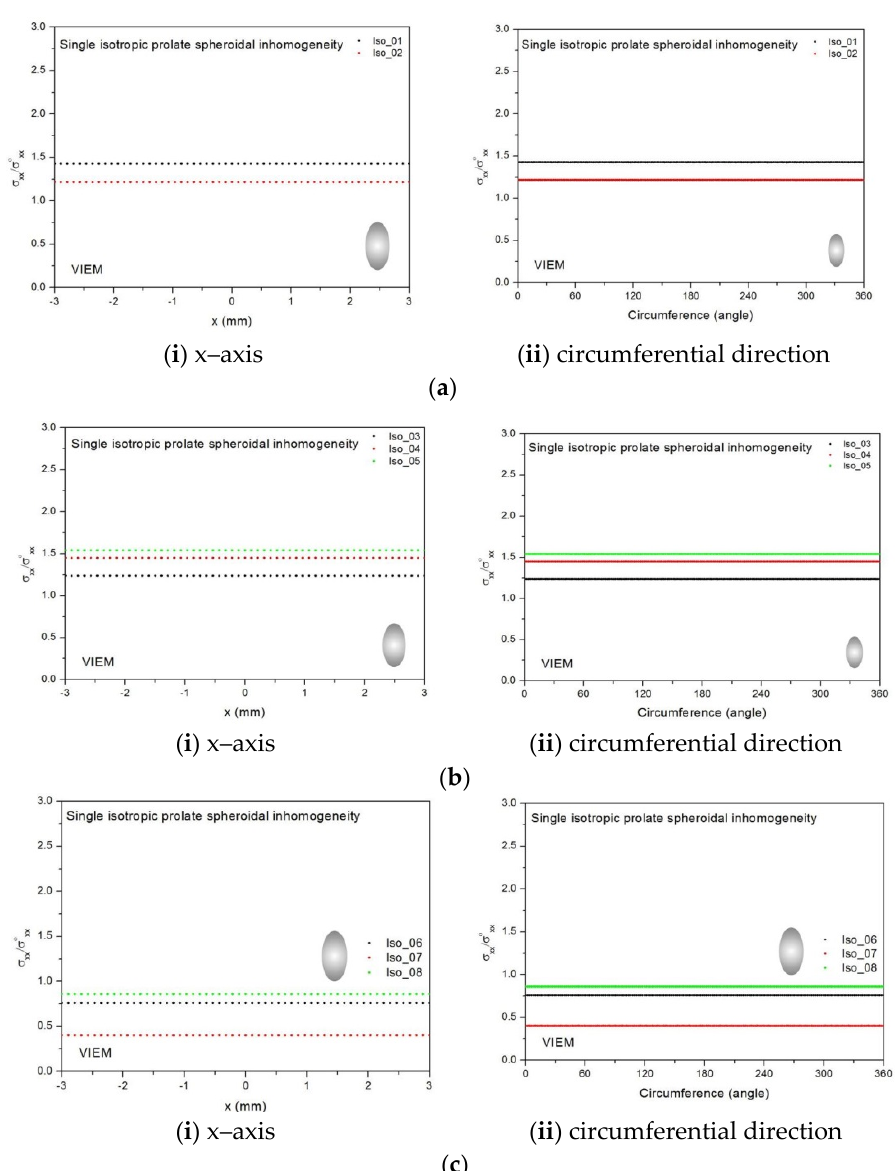
Figure 11. A typical discretized prolate spheroidal model (a/b = c/b = 0.75) in the volume integral equation method (VIEM). ( a ) An inside view of a prolate spheroidal model. ( b ) A prolate spheroidal model. Tables 10–12 show numerical solutions by the volume integral equation method for the normalized tensile stress ( σ xx / σ oxx ) inside the isotropic prolate spheroidal inclusions. For the inclusions in Iso_01, Iso_02, Iso_03, Iso_04 and Iso_05, the normalized tensile stress ( σ xx / σ oxx ) inside the inclusion was greater than 1.0. However, for the inclusions in Iso_06, Iso_07 and Iso_08, the normalized tensile stress ( σ xx / σ oxx ) inside the inclusion was less than 1.0. Figure 12 shows numerical solutions by the volume integral equation method for the normalized tensile stress ( σ xx / σ oxx ) along (i) the x–axis inside ( − 3 mm ≤ x ≤ 3 mm) and (ii) the circumferential direction (0° ≤ Ө (see Figure 10) ≤ 360°) of the isotropic prolate sphe- roidal inclusions (a/b = c/b = 0.5 where b = 6 mm) under uniform remote tensile loading.